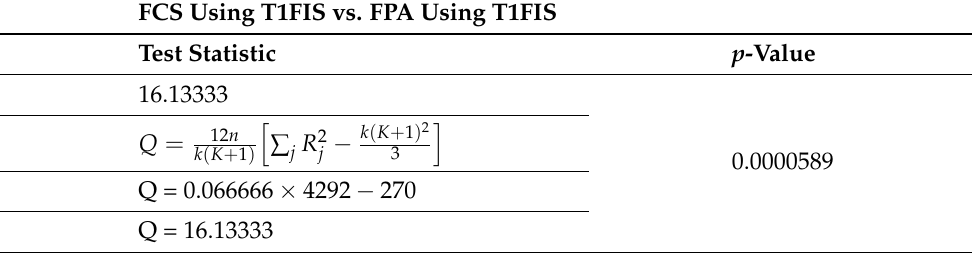
Table 12. Friedman test in comparing FCS Using ST2FIS vs. FPA Using ST2FIS for TTCFNLC with abrupt actuator fault